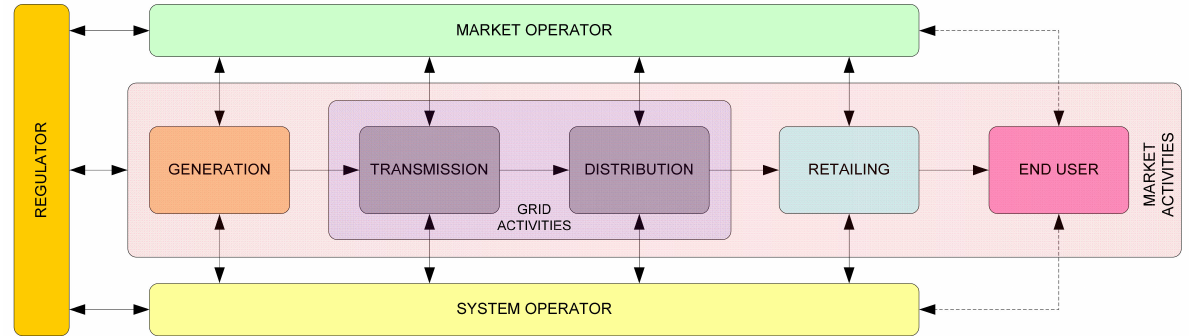
Figure 3. Traditional wholesale electricity